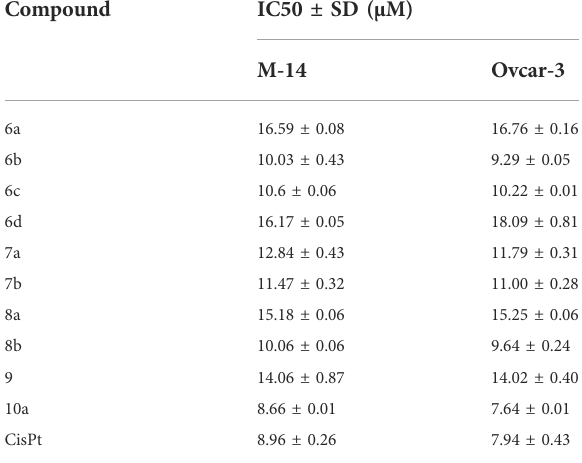
TABLE 6 Anticancer activities of selected compounds in DMSO